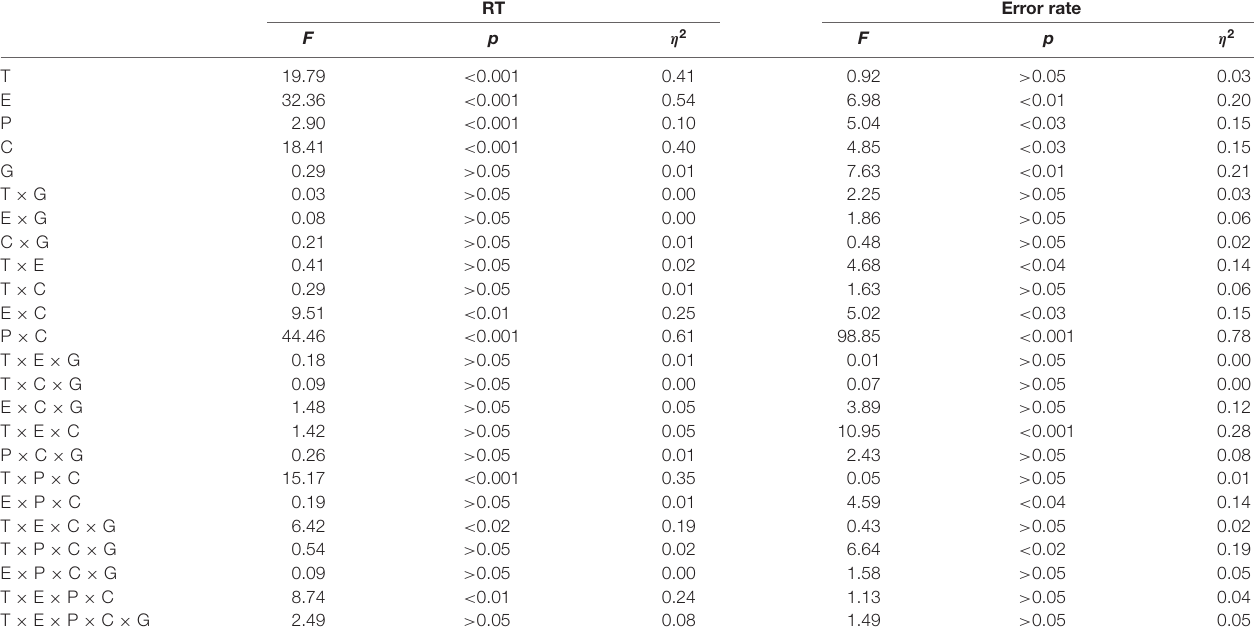
TABLE 2 | Results of the ANOVAs of reaction time and error rates in 5-year-old children. RT Error rate F p η 2 F p η 2